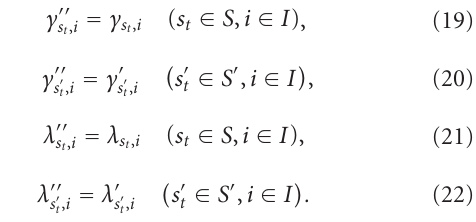
Algorithm 1 is an example of the state-transition model written in the XML